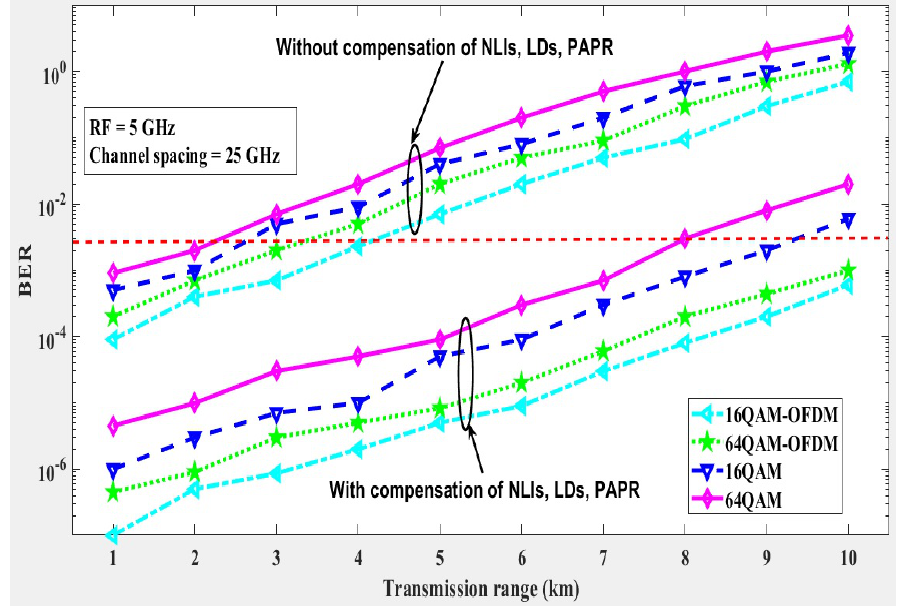
Figure 7. BER versus transmission range for modulation signals with 16QAM (Non-OFDM), 64QAM (Non-OFDM), 16QAM-OFDM and